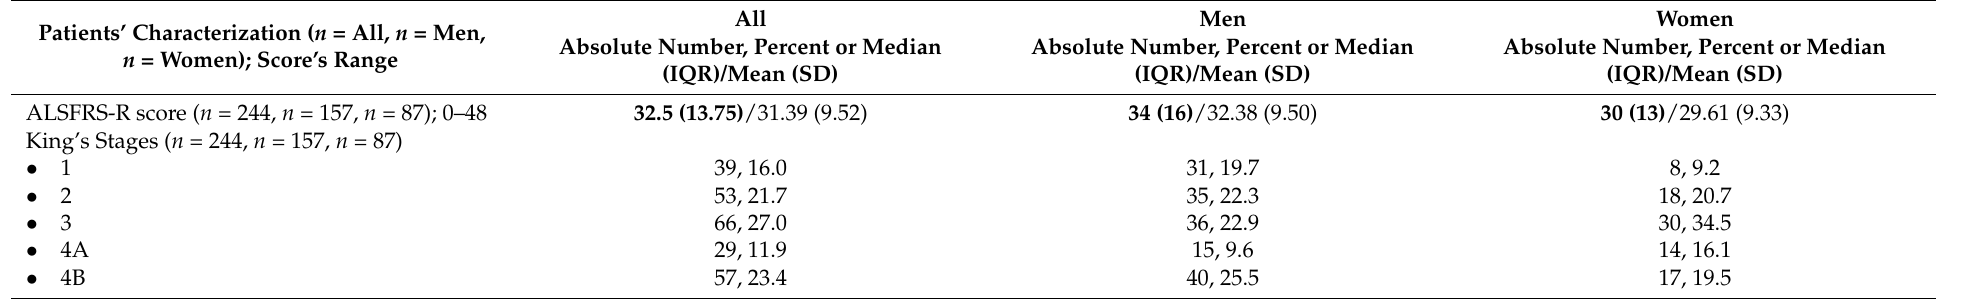
Patients’ Characterization ( n = All, n = Men,